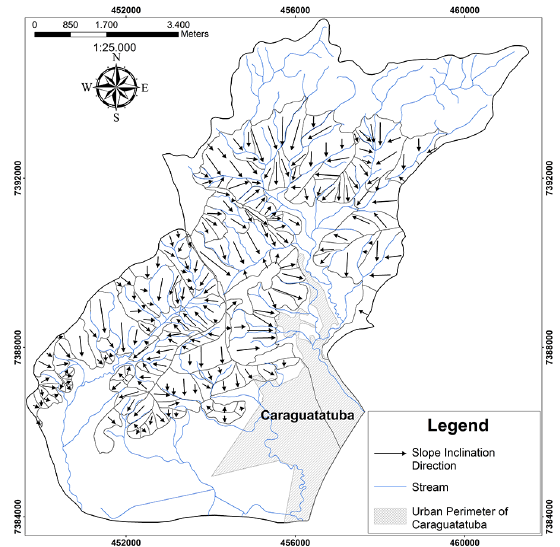
Figure 2 - Northeastern region of Caraguatatuba and the division of slopes according to their inclination